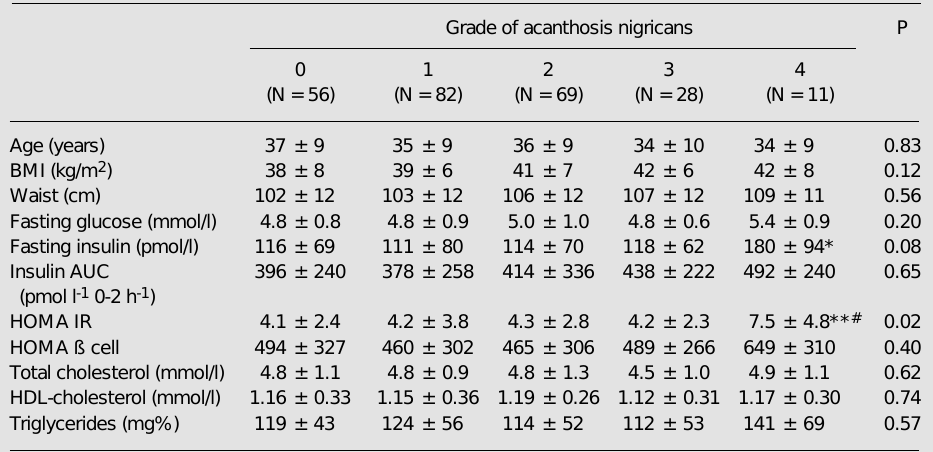
Table 1. Clinical and metabolic parameters for the groups of obese women. Grade of acanthosis